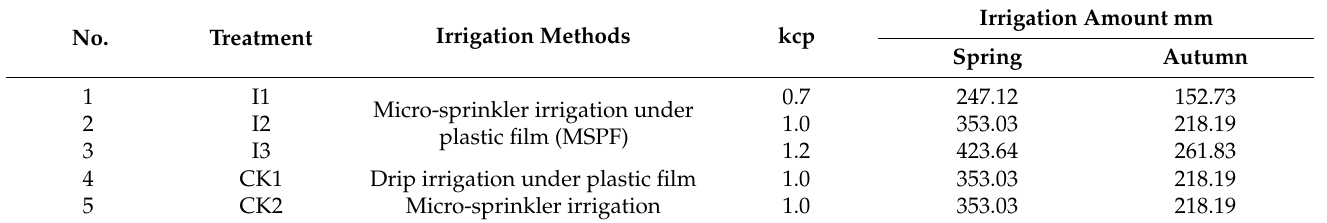
Table 2. Experimental factor and